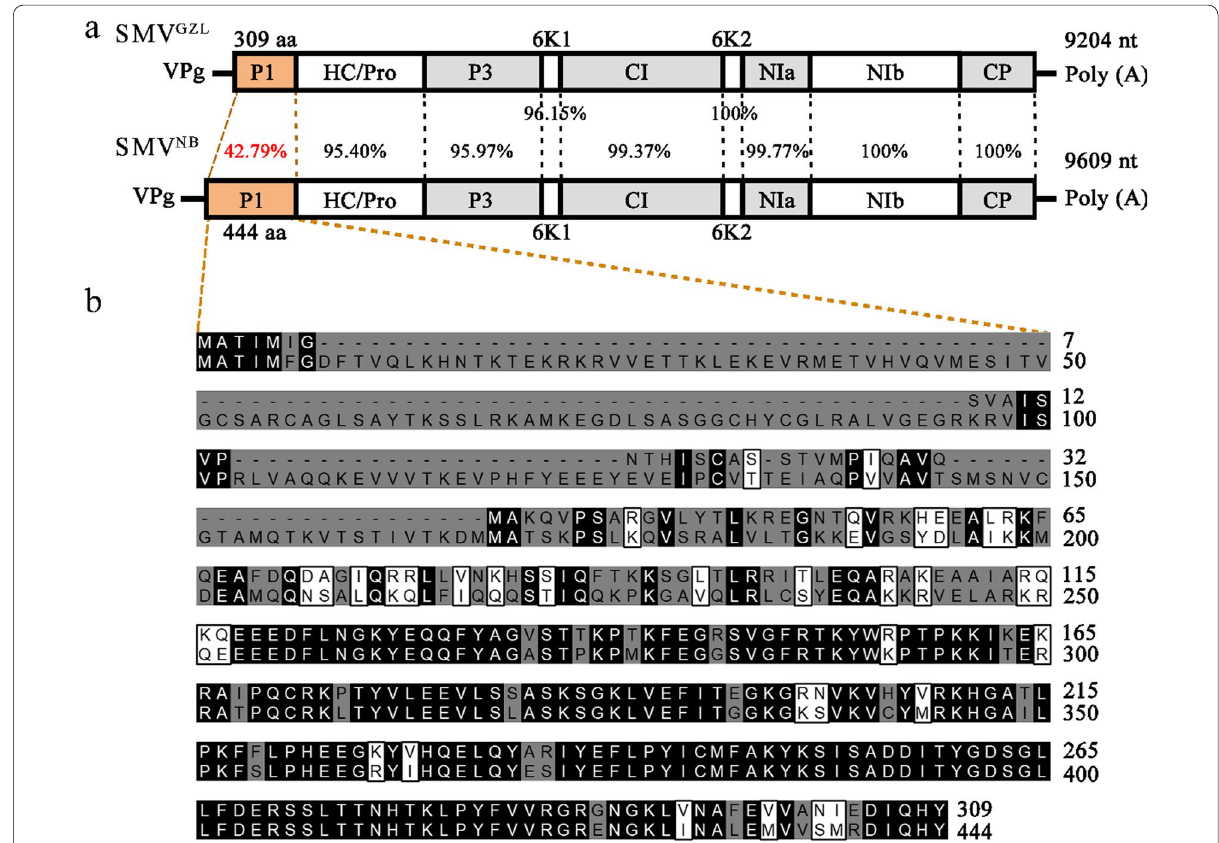
Fig. 4 The genome organization and sequence comparisons of SMV isolates SMV NB and SMV GZL . a Diagrams showing the genome organization of isolates SMV NB and SMV GZL and the encoded proteins for each cistron. The percentage of nucleotide sequence identity for each cistron is shown between the two diagrams. b The alignment of P1 amino acid sequences from SMV NB and SMV GZL was performed using